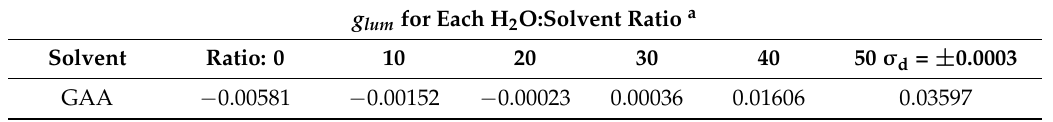
Table 6. Luminescence dissymmetry ratio values ( g lum ) for [Tb(DPA) 3 ] 3 − with varying ratios of H 2 O:glacial acetic acid (GAA).